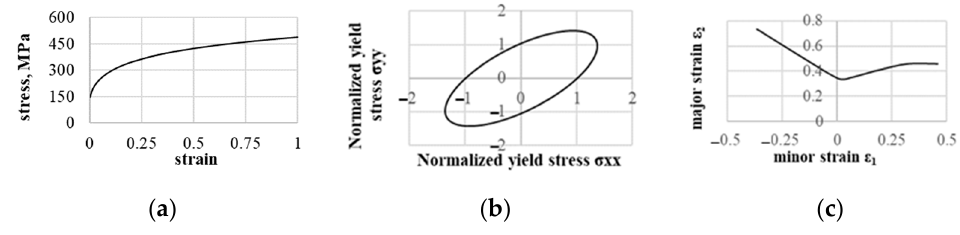
Figure 3. ( a ) Flow curve, ( b ) yield surface, and ( c ) FLC of DC05 steel.